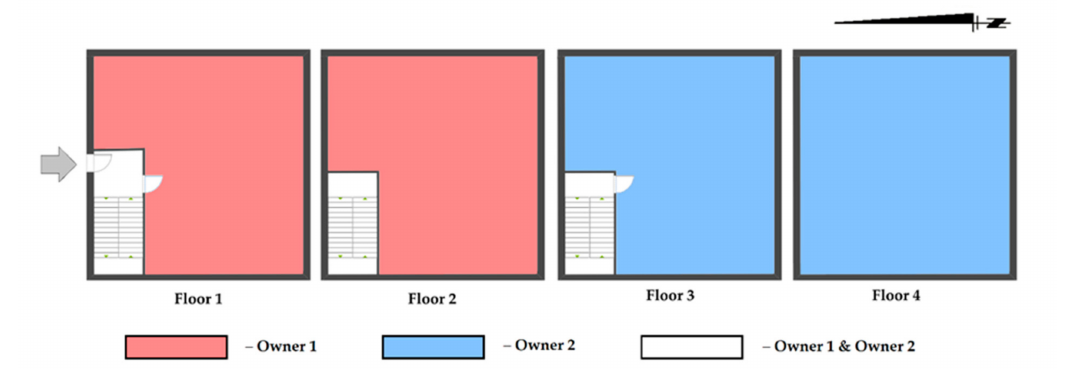
Figure 11. Legal space of the building no. 89 / 1;1.